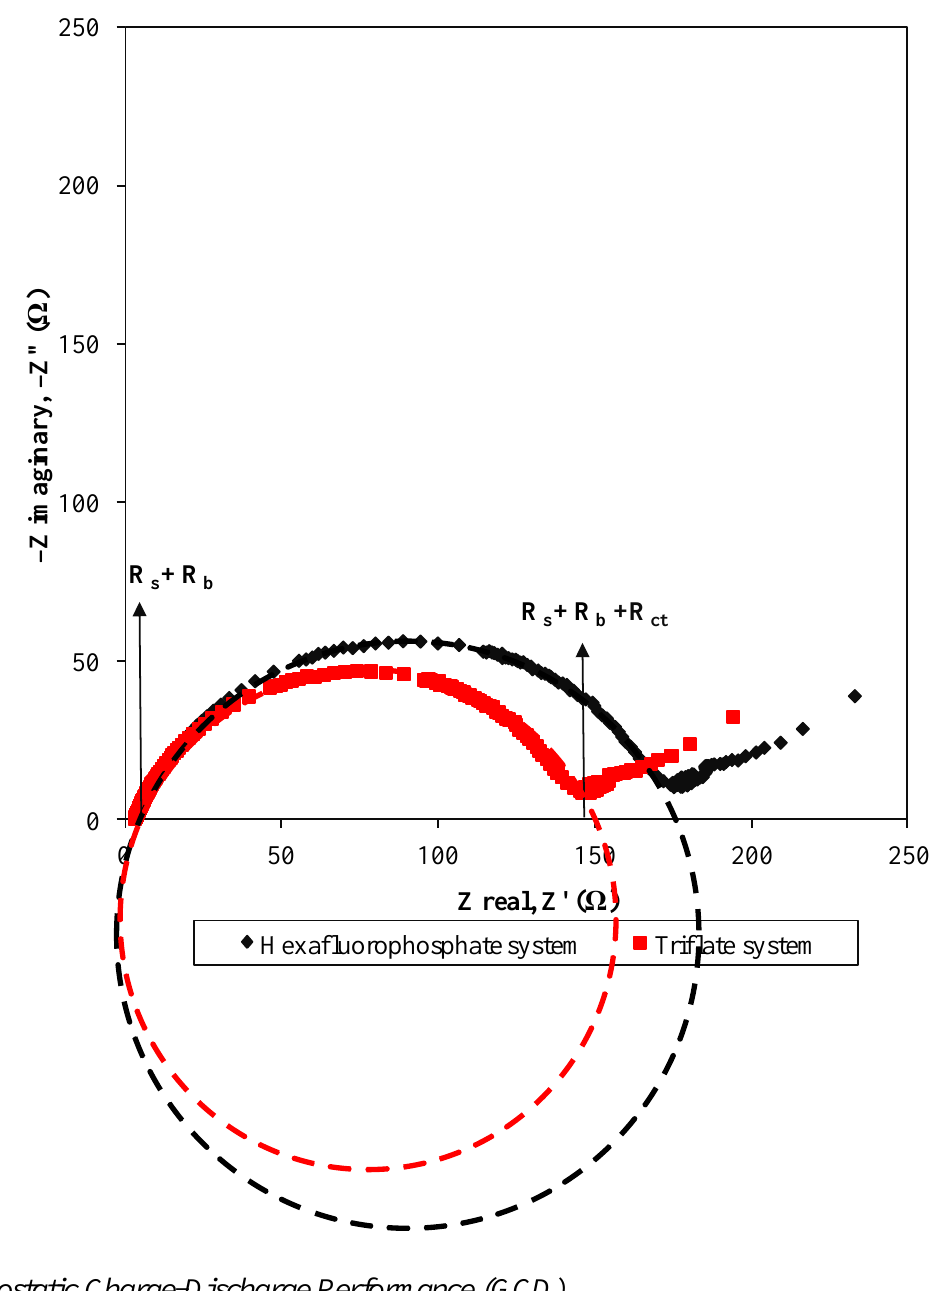
Figure 6. Nquist plots of EDLCs using both systems.